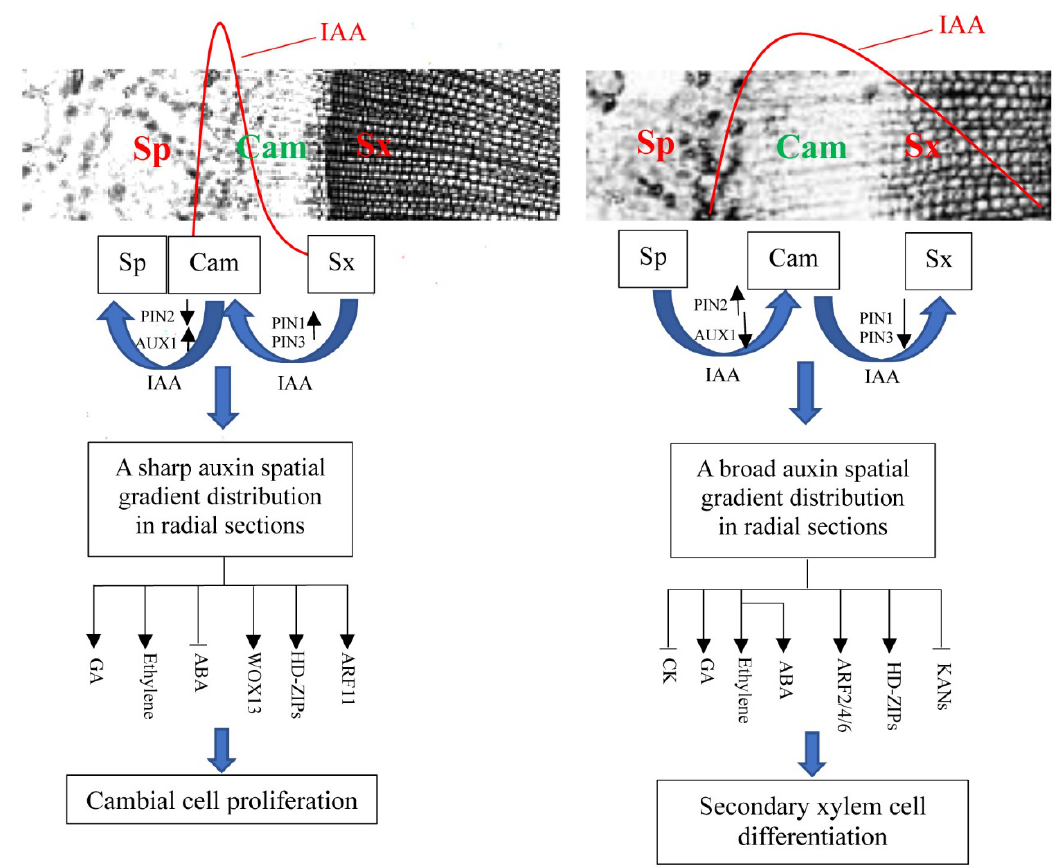
Figure 9. A proposed model whereby the auxin concentration gradient across tree trunks is involved